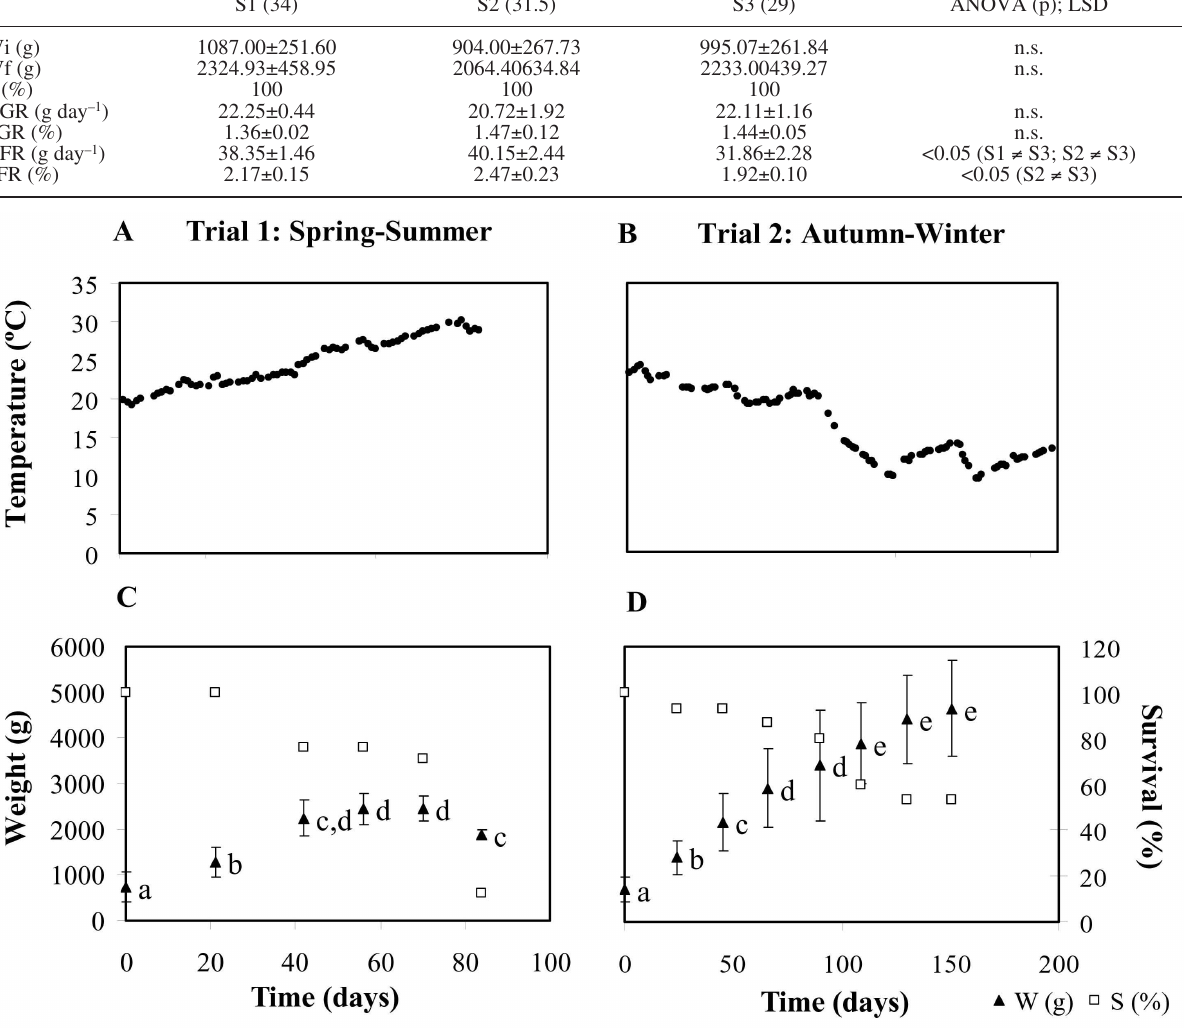
Fig . 2. – A and B, daily water temperature during the two trials (Experiment 1: effects of temperature). C and D, variation of octopus mean weight (W) ± SD and survival (S) during the different thermal periods. Graphs are on different scales. Values with different superscripts are significantly different